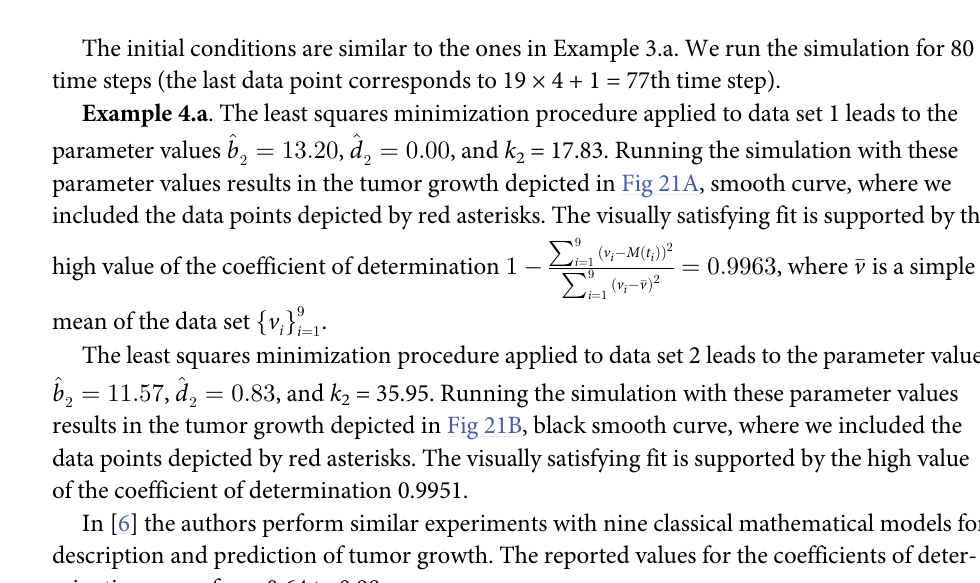
The initial conditions are similar to the ones in Example 3.a. We run the simulation for 80 time steps (the last data point corresponds to 19 × 4 + 1 = 77th time step).